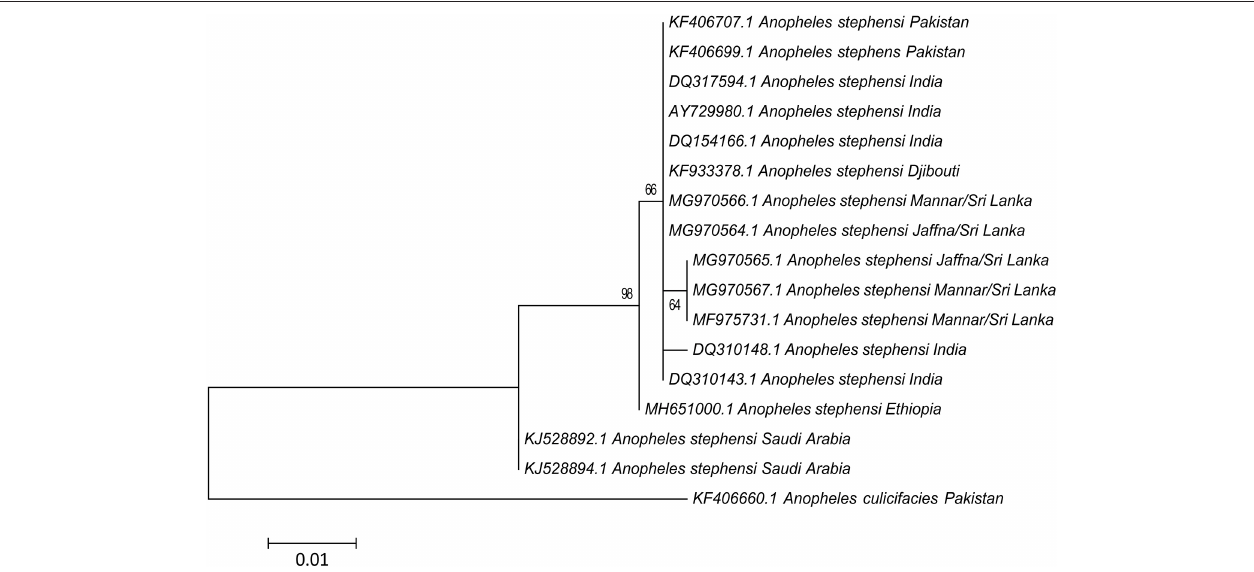
FIGURE 4 | Phylogenetic analysis based on cox1 sequences (367 nucleotide positions) constructed using the maximum likelihood method and Tamura 3-parameters showing bootstrap values > 60%. The sequences used for analysis include samples from Jaffna (GenBank: MG970564 and MG970565), Mannar (GenBank: MG970566 and MG970567) described in this study and other available GenBank entries. Anopheles culicifacies (GenBank: KF406660) was used as the outgroup.